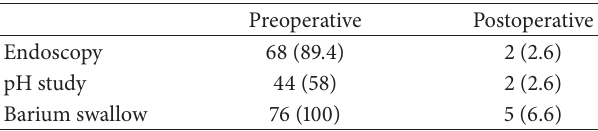
Table 1: Investigations of patient symptoms ( 𝑛 = 76; percentages in